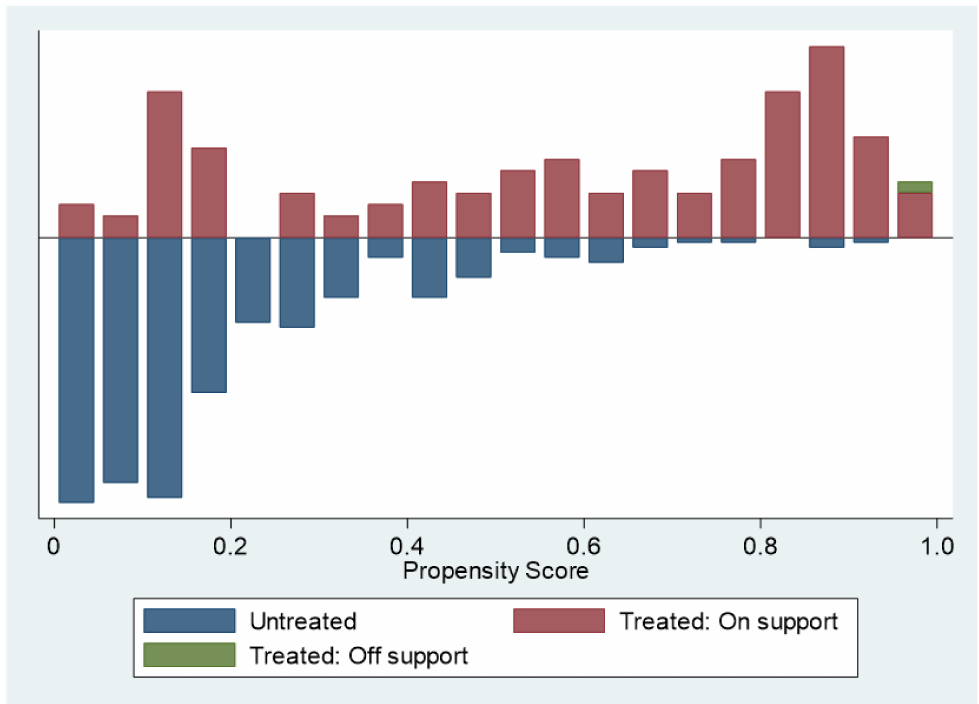
Figure 4. Density of the propensity scores and common support for indigenous fruit and vegetable farmers relative to non-indigenous fruit and vegetable